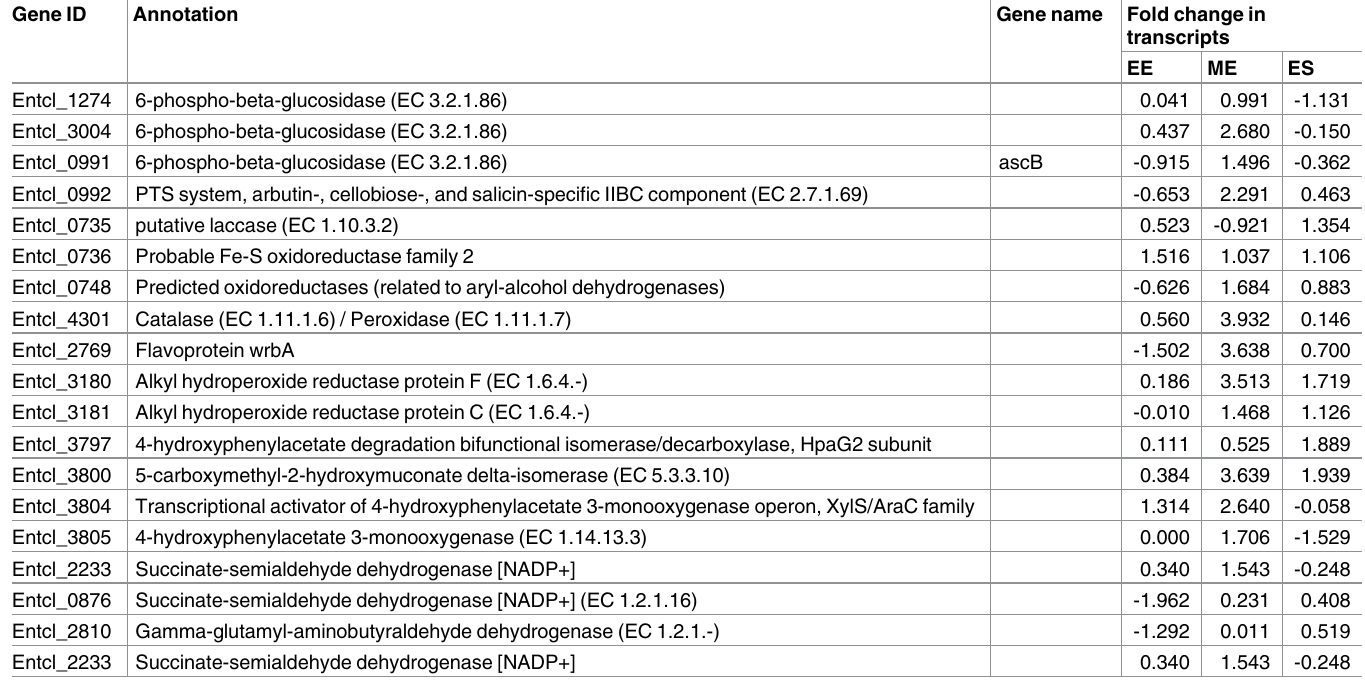
Table 3. Genes differentially regulated during growth related to lignin degradation. Differential expressionwas definedas transcripts with adjustedp- values < 0.05 and absolute value of log2 fold change > 1 for these